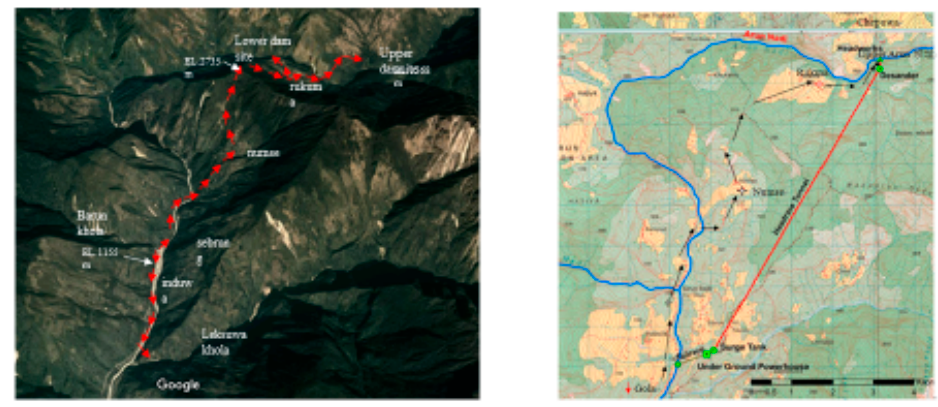
Figure A6. Field investigation route from Barun Khola to lower dam